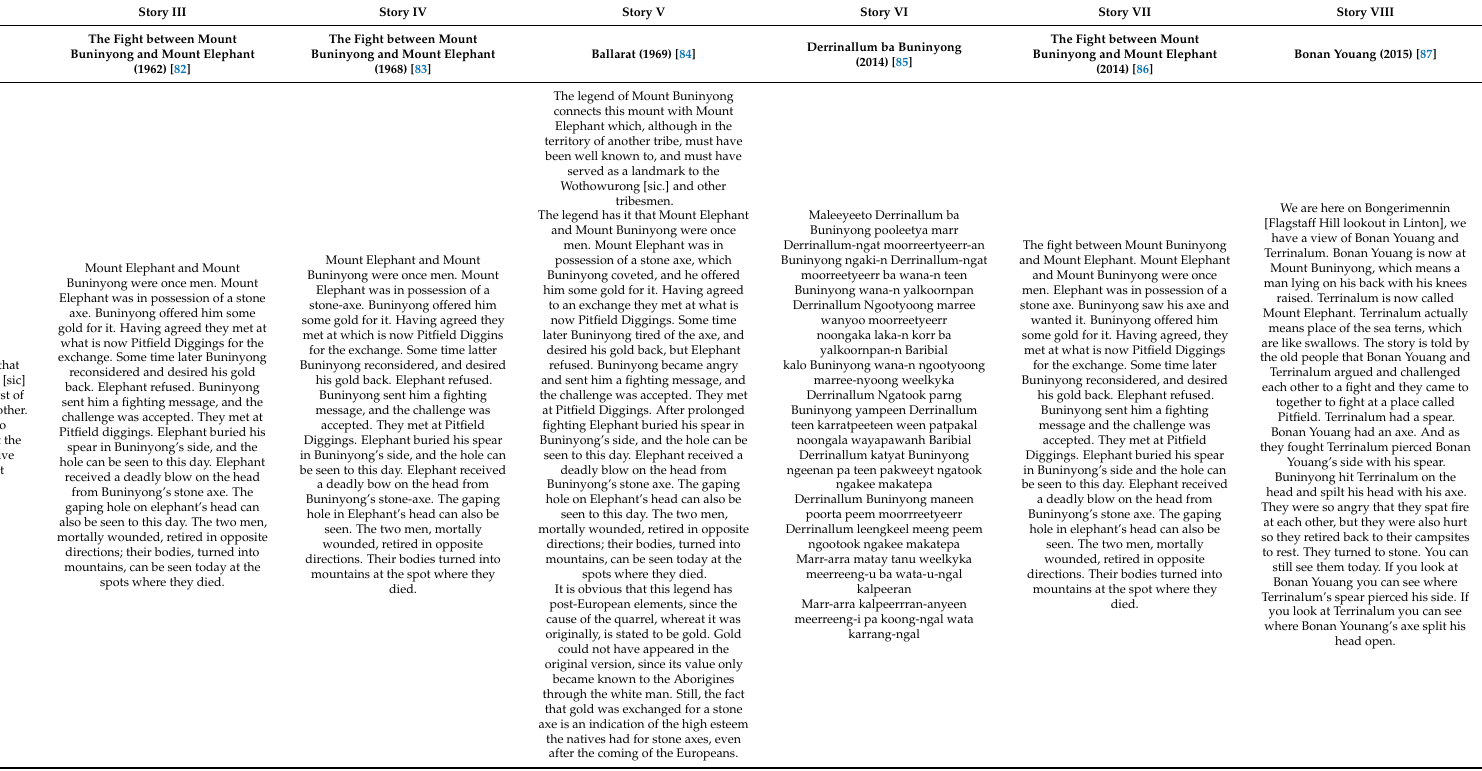
Table 2. Stories about Bonan Youang/Mount Buninyong and Terrinalum/Mount